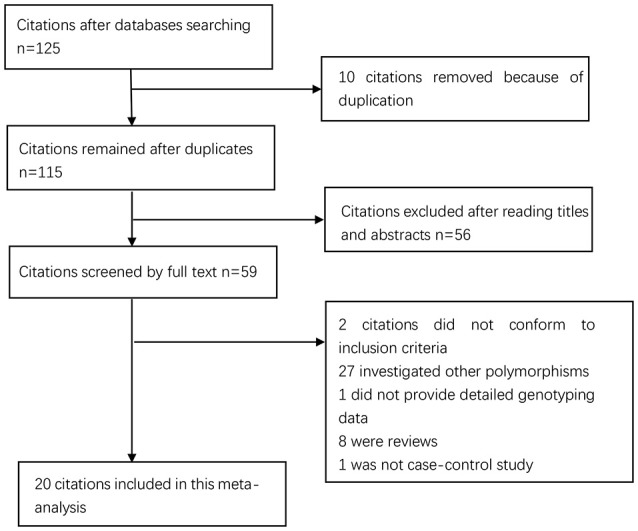
Selection for eligible papers included in this meta-analysis.